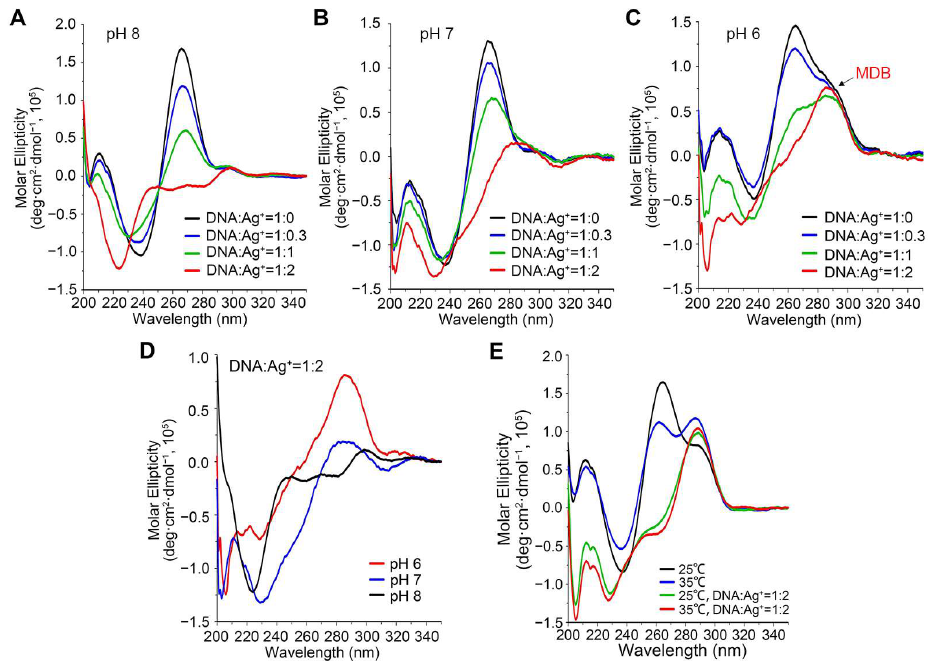
Figure 3. CD spectra of 15 μM CCTG 2 and CAGG 2 with 0, 5, 15, and 30 μM Ag + in 10 mM NaPi at pH 8 ( A ), pH 7 ( B ), and pH 6 ( C ). ( D ) CD spectra of 15 μM CCTG 2 and CAGG 2 in 30 μM Ag + at pH 8, 7, and 6 at 25 °C. ( E ) CD spectra of 15 μM CCTG 2 and CAGG 2 without Ag + and with 30 μM Ag + (pH 6) at 25 °C and 35 °C. Absorbance at 290 nm is characteristic of the free CCTG MDB.